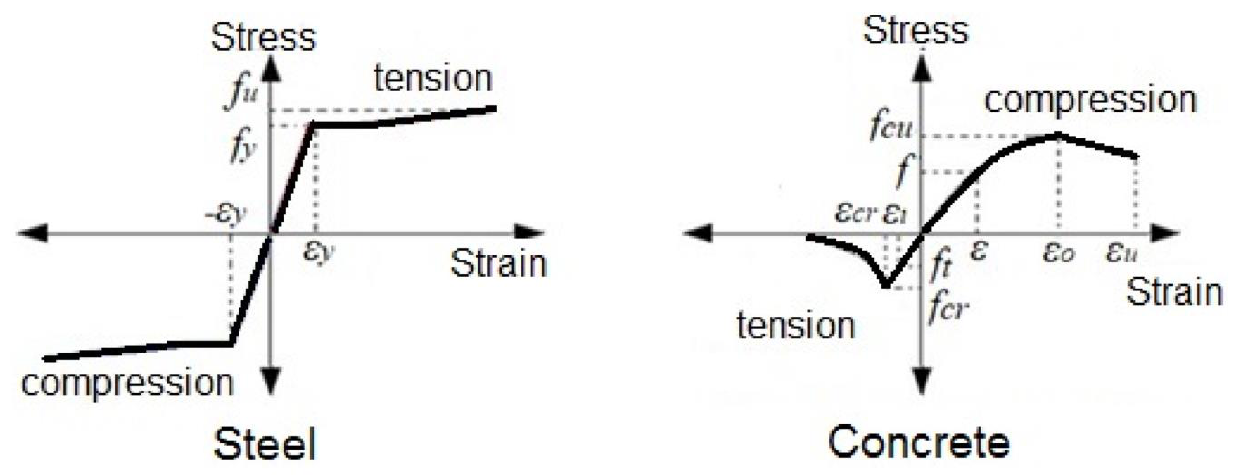
Figure 17. Materials constitutive stress–strain models.